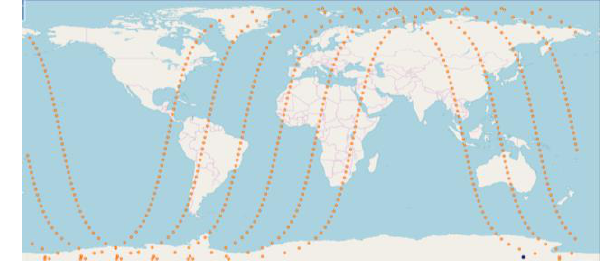
Figure 5: Simulated polar-orbiting Worldview-4 orbital